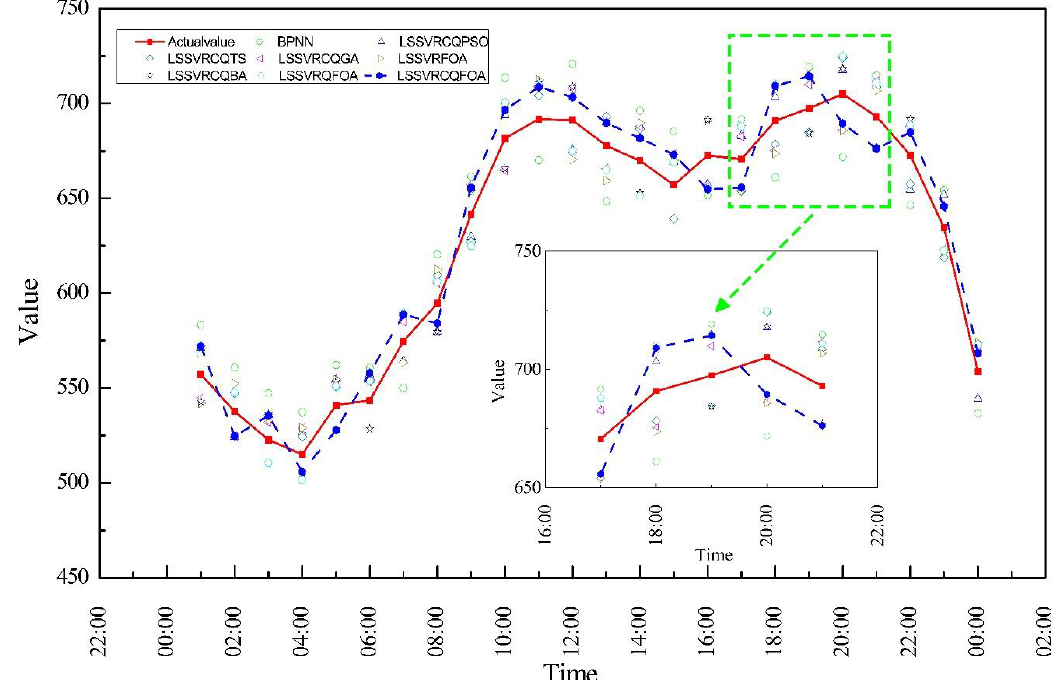
Figure 2. Forecasting values of LS-SVR-CQFOA and other models for IDAS 2014.